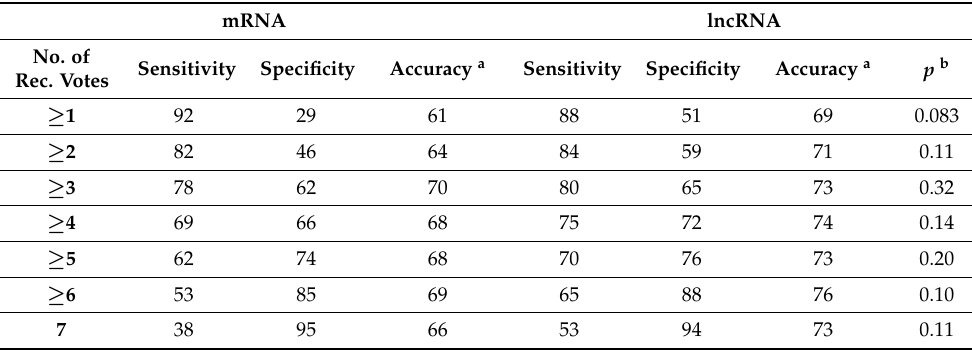
Table 5. Integrated voting results following classification using balanced accuracy optimization. mRNA lncRNA No. of Rec.